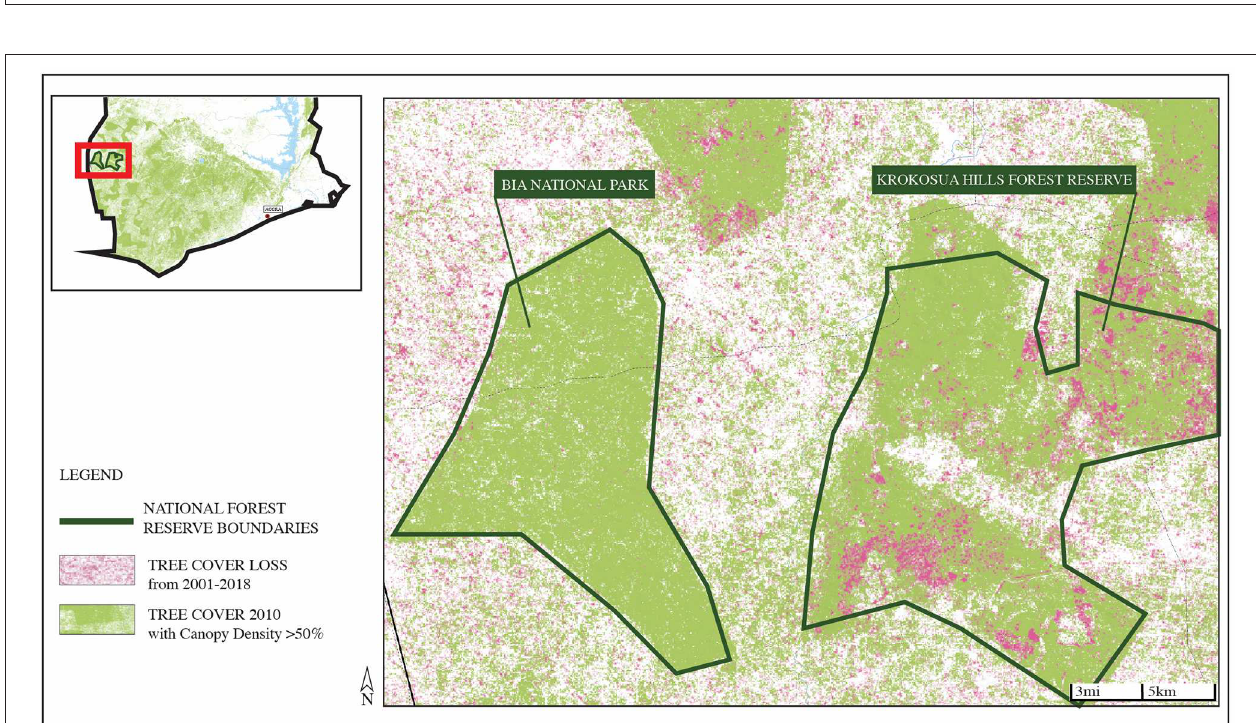
FIGURE 2 | Map showing deforestation adjacent to, and within, the Bia National Park and the Krokosua Hills Forest Reserve in the Juaboso-Bia district. Source: World Resources Institute (2019) and author’s own creation.